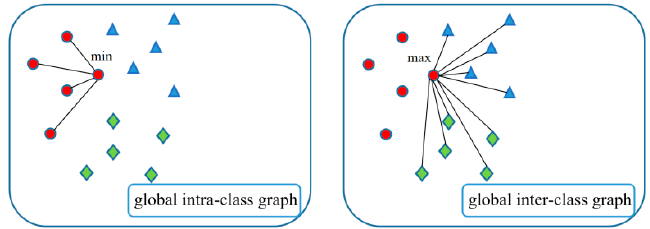
Figure 2. Example of global graph construction.